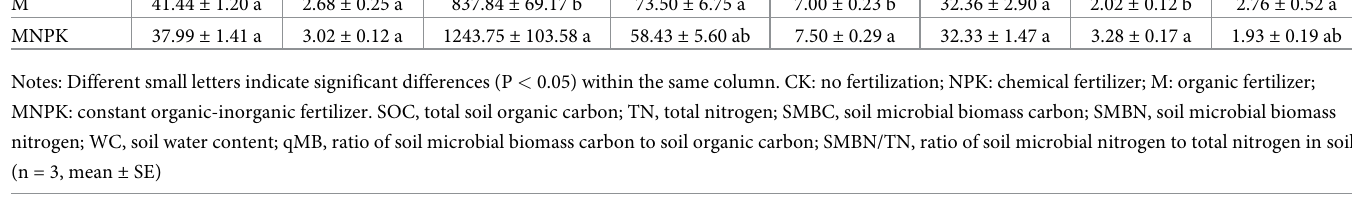
The first-order kinetic equation was used to fit the cumulative mineralization of soil organic carbon by Origin 9.0 [14],